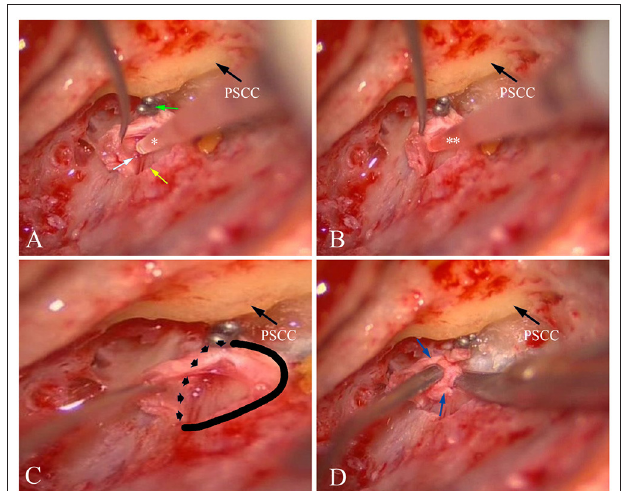
FIGURE 2 | Sampling ELF and collecting ES specimen from patient no. 8 with left MD. (A) After blockage of the distal intraosseous portion of the ES using two titanium clips (green arrow) and exposure of the lumen of the ES (yellow arrow), a small amount of fluid (endolymph) could be found (white arrow). Then, 2 µ l sterile water (*) was infused into the lumen of the ES. (B) 2 µ l diluted luminal fluid (**) was aspirated from ES. (C) A solid and dotted line was used to mark the border of the ES specimen that would be resected. (D) An ES specimen including the distal intraosseous and proximal extraosseous (lateral side) portions (blue arrow) of the ES was resected. PSCC, posterior semicircular canal; ES,endolymphatic sac; ELF, ES luminal fluid; MD, Meniere’s